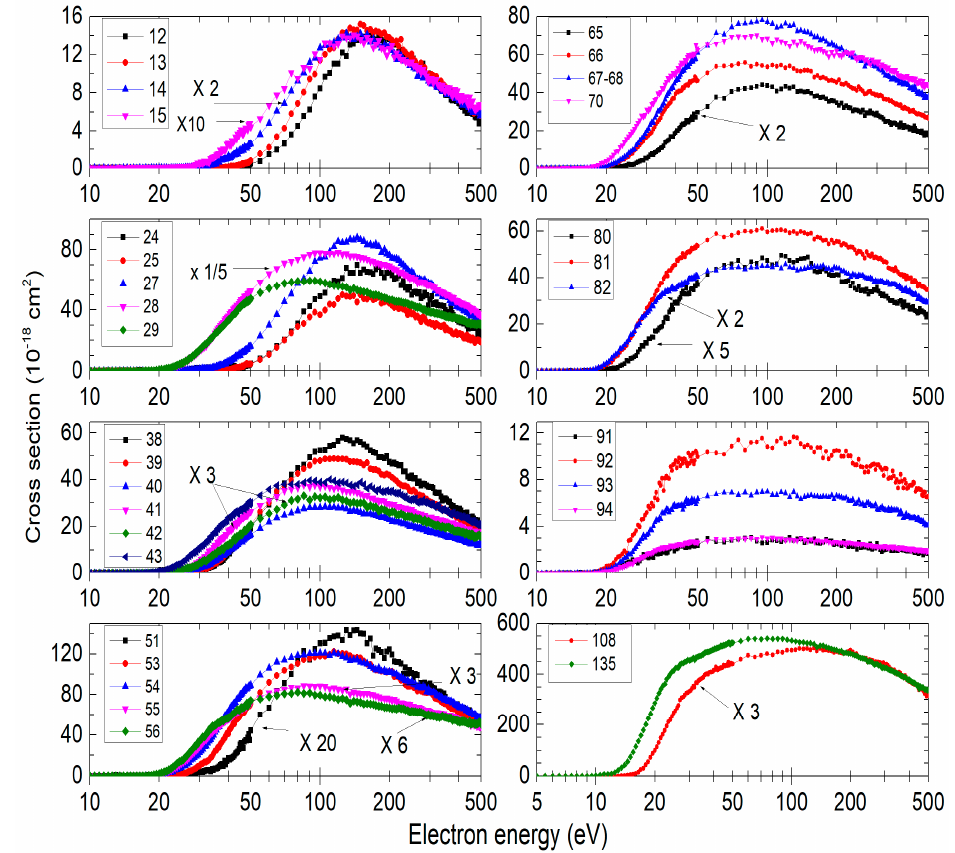
Figure 4. Partial ionization cross sections for all dominant ions from adenine. The numbers in the top left side of the panels represent the m / z values; 67–68 represent three ions of m / z = 67, 67.5, and 68, with 67.5 being the dominant one corresponding to doubly charged parent ion, C 5 H 5 N 52+ .